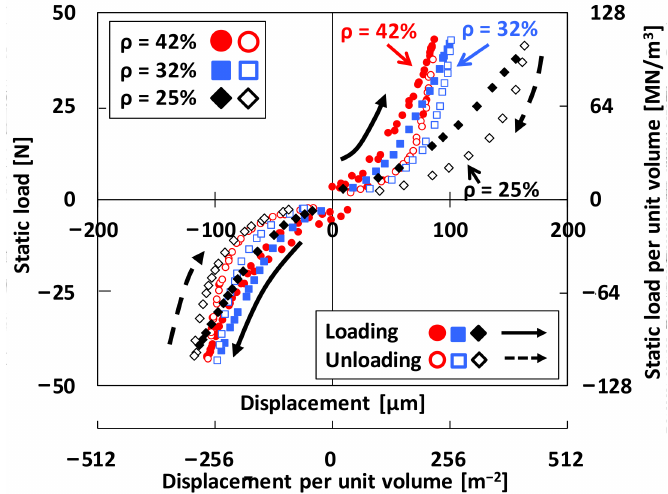
Figure 5. Full hysteresis loop measurements: Applied static load (left vertical axis) and static load per unit volume (right vertical axis) versus recorded displacement (upper horizontal axis) and displacement per unit volume (lower horizontal axis) for the test WMDs during loading and unloading cycles. The circle, square, and diamond symbols denote the structural stiffnesses of the WMDs with 42%, 32%, and 25% densities,